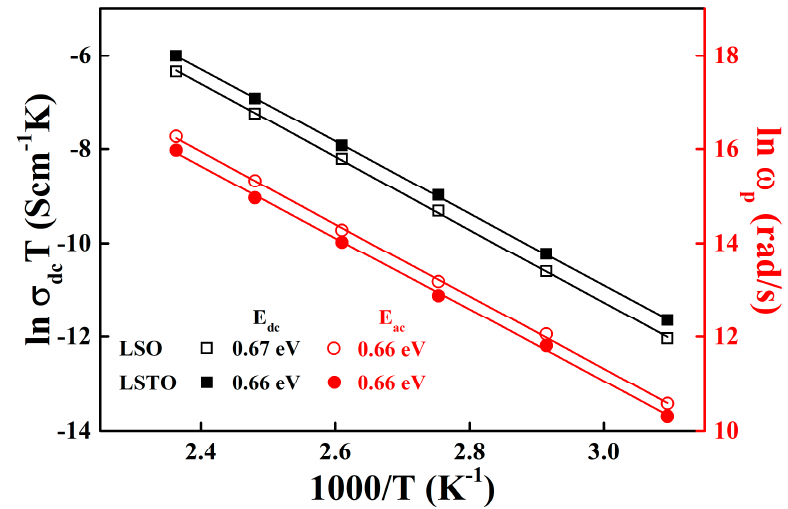
Figure 3. Temperature dependence of the dc conductivity (black: left vertical axis) and the conductivity relaxation peak frequency, ω p , (red: right vertical axis) obtained from the complex impedance Cole − Cole analysis for LSO (opened symbols) and LSTO (closed symbols) glasses. The solid lines are the least ‐ squares straight ‐ line fits to the data.